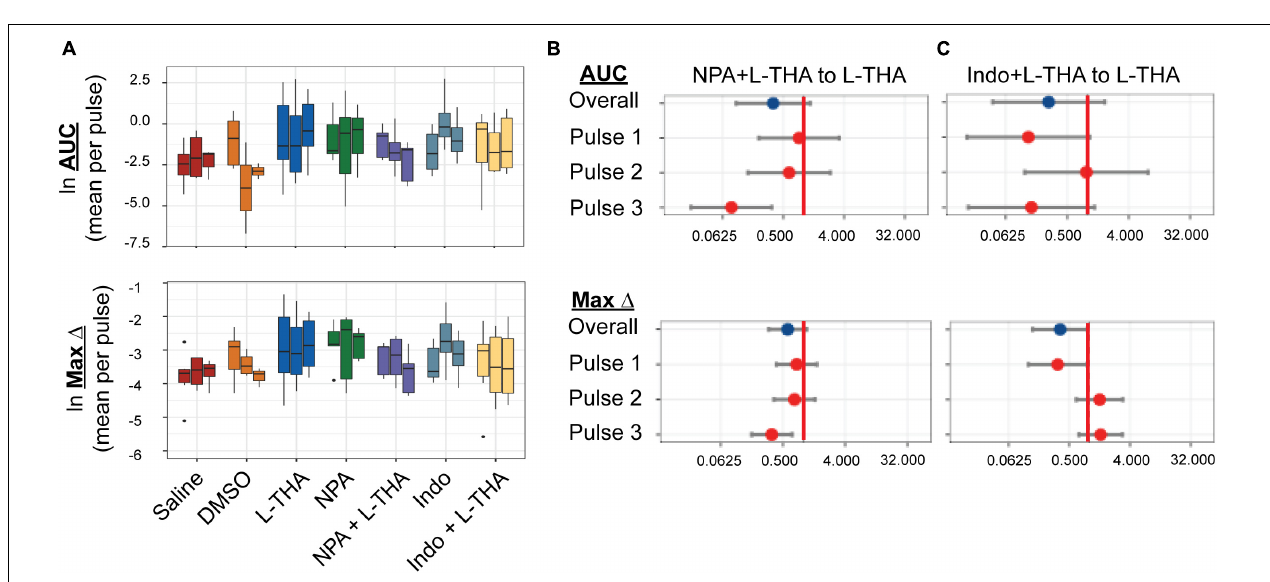
FIGURE 8 | Effects of saline, L-THA, L-NPA, Indomethacin, and L-NPA or Indomethacin with L-THA on arteriole diameter. Saline, L-THA (100 µ M), L-NPA (2 µ M), Indomethacin (10 µ M), or a combination of NPA or Indomethacin with L-THA were picospritzed near cortical arterioles. (A) Data are presented as boxplots. Forest plots are also included to show the mean differences expressed as ratios of the effect observed with NPA with L-THA (B) or Indomethacin with L-THA (C) over that observed with L-THA. The redline is at 1 and represents no difference. The data for saline and L-THA are described in Figure 4 legend, the data for NPA are from 5 animals (4 males, 1 female), the data for NPA with L-THA are from 5 animals (3 males, 2 females), the data from Indomethacin are from 8 animals (3 males, 5 females) and the data for Indomethacin with L-THA are from 6 animals (3 males, 3